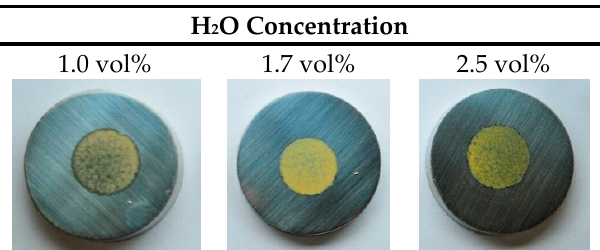
Figure 7. Photographs of 304L SS after anodizing in glycerol electrolyte containing 0.05 M Na 2 SiO 3